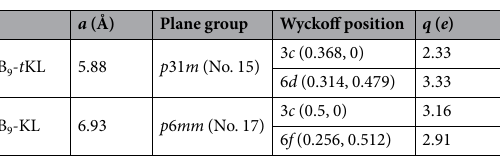
Table 1. The calculated lattice constants ( a ), plane groups, Wyckoff positions, and Bader charges ( q ) are compared for